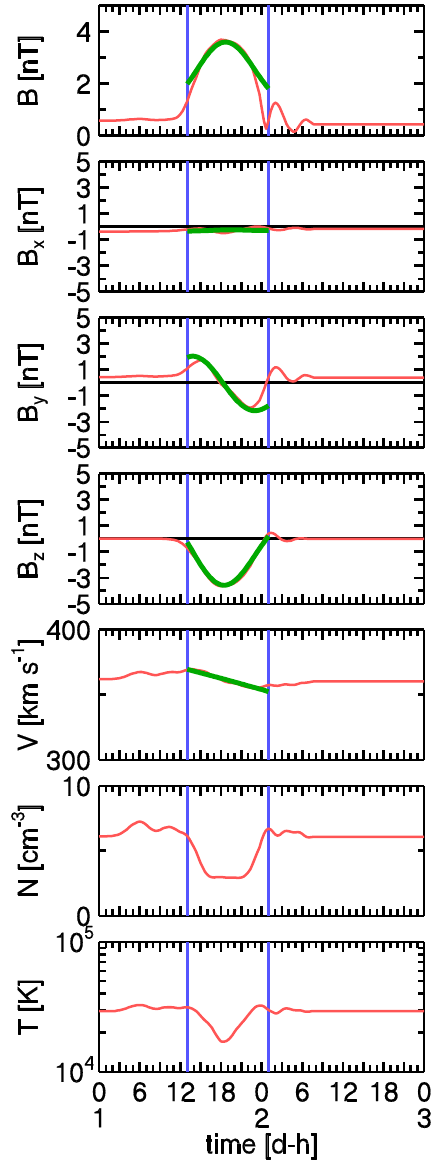
Fig. 9. Simulated time profiles at the point A for a flux rope inclined 90 ◦ to the ecliptic plane. The layout is similar to Fig.